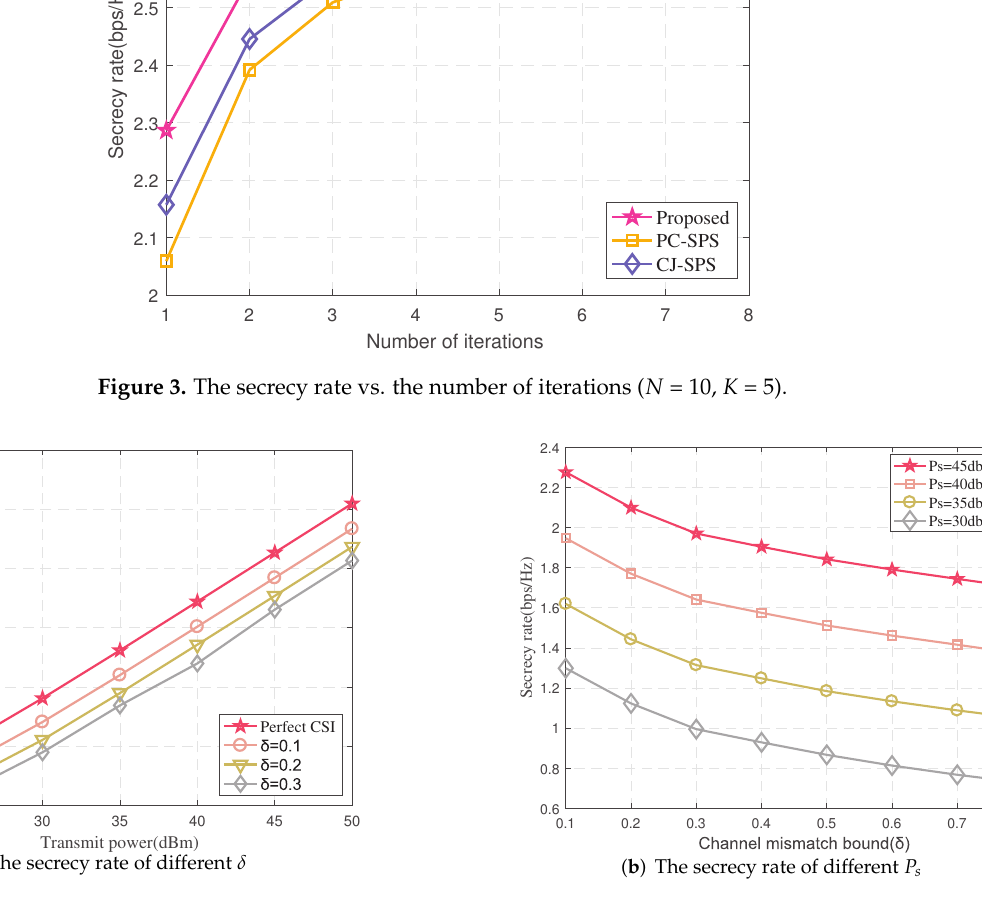
Figure 4. The secrecy rate vs. P s and δ ( N = 10, K =